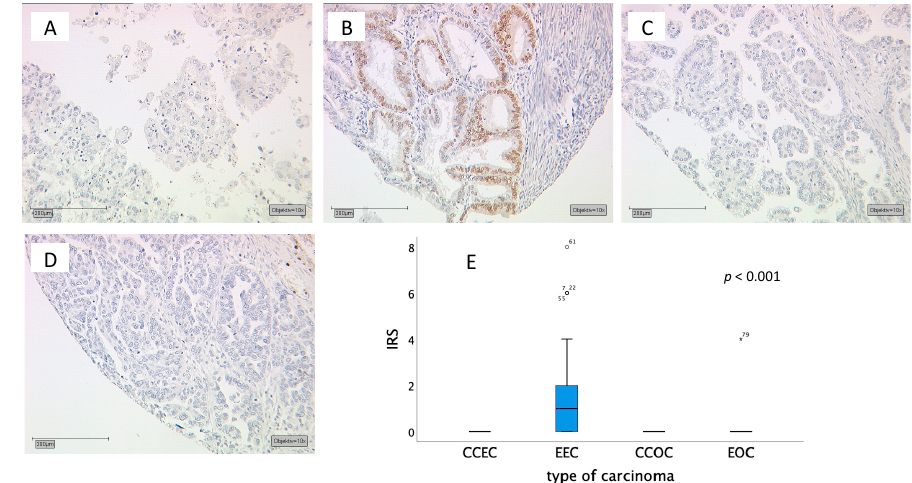
Figure 1. ( A – D ) Tumor samples stained for MSX1: ( A ) Clear cell endometrial carcinoma with an immunoreactive score (IRS) of 0; ( B ) Endometrioid endometrial Carcinoma with an IRS of 2; ( C ) Clear cell ovarian carcinoma with an IRS of 0; ( D ) Endometrioid ovarian carcinoma with an IRS of 0; ( E ) Boxplots with a median IRS of 1 for endometrioid endometrial carcinomas (EEC) and with a median IRS of 0 for clear cell endometrial carcinomas (CCEC), clear cell ovarian carcinomas (CCOC) and endometrioid ovarian carcinomas (EOC). The circle indicates values more than 1.5 box lengths from the 75th percentile. Asterisks indicate values which are more than 2times the box length. Numbers at circle and asterisks indicate sample number.